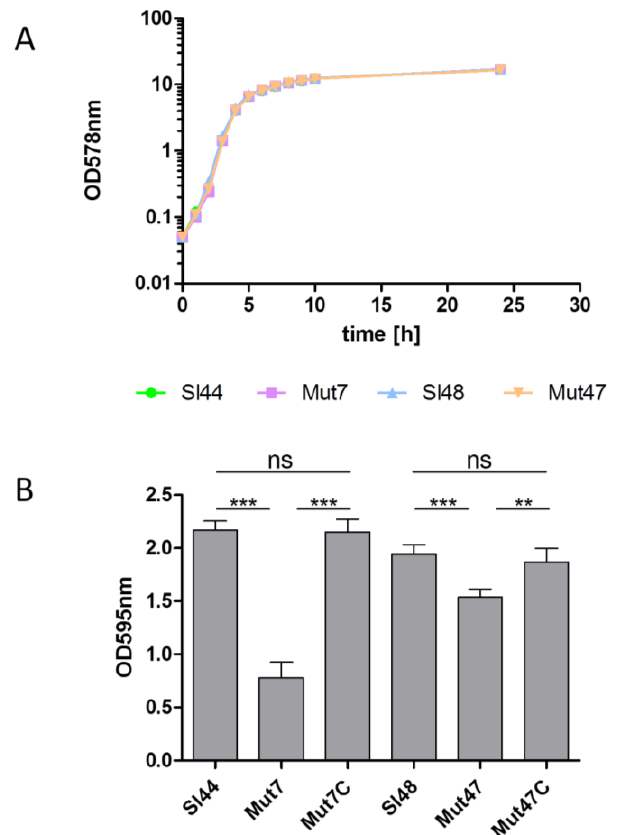
Figure 4. Growth and biofilm formation of S. lugdunensis wild-type strains (Sl44, Sl48) and ∆ srtA mutant strains (Mut7, Mut47). ( A ) Bacterial growth was monitored for 24 h. Bacteria were cultivated in 100 mL BHI in 500 mL flask at 37 ◦ C under permanent agitation. The experiment was done on triplicates. One representative experiment is shown. ( B ) Biofilm-forming capacities of the S. lugdunensis wild type (Sl44 and Sl48), ∆ srtA mutant (Mut7 and Mut47) and complemented mutant (Mut7C and Mut47C) strains were assessed by a quantitative biofilm assay performed in microtiter plates applying crystal violet and determination of the OD 595nm . Results are shown as the mean of five independent experiments with the standard deviation (SD). Statistical analyses were performed using one-way ANOVA with Bonferroni multiple comparisons posttest (** p < 0.01; *** p < 0.001). ns—not significant.